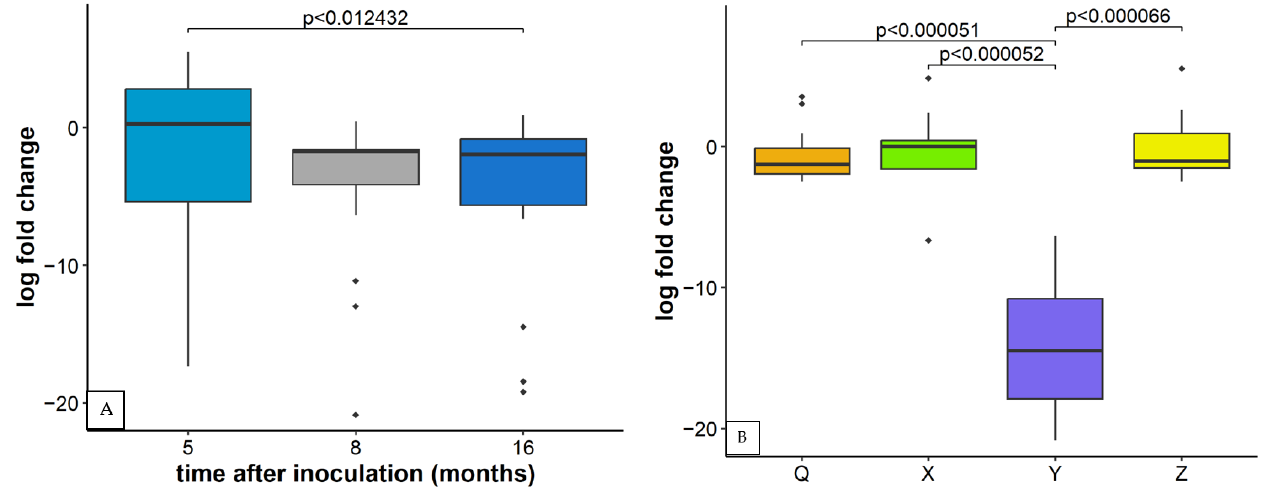
Figure 4. ( A ) Relative concentration of GVA based on CP region five, eight, and 16 months after inoculation observed in inoculated plants of all varieties. Results are displayed as a logarithmic ratio of relative concentration. ANOVA test was performed along with Bonferroni posthoc test and significantly different values ( p < 0.05) are marked over individual box plots. ( B ) Multiple comparisons of relative concentration of GVA based on CP region five months after inoculation in plants of all varieties harboring the same inoculum. Results are displayed as a logarithmic ratio of relative concentration. ANOVA test was performed along with the Bonferroni post hoc test and significantly different values ( p < 0.05) are marked over individual box plots. In both cases, Outlier measurements that are 1.5 times over the upper/lower quartile of the dataset of an individual boxplot are marked with ◆ .